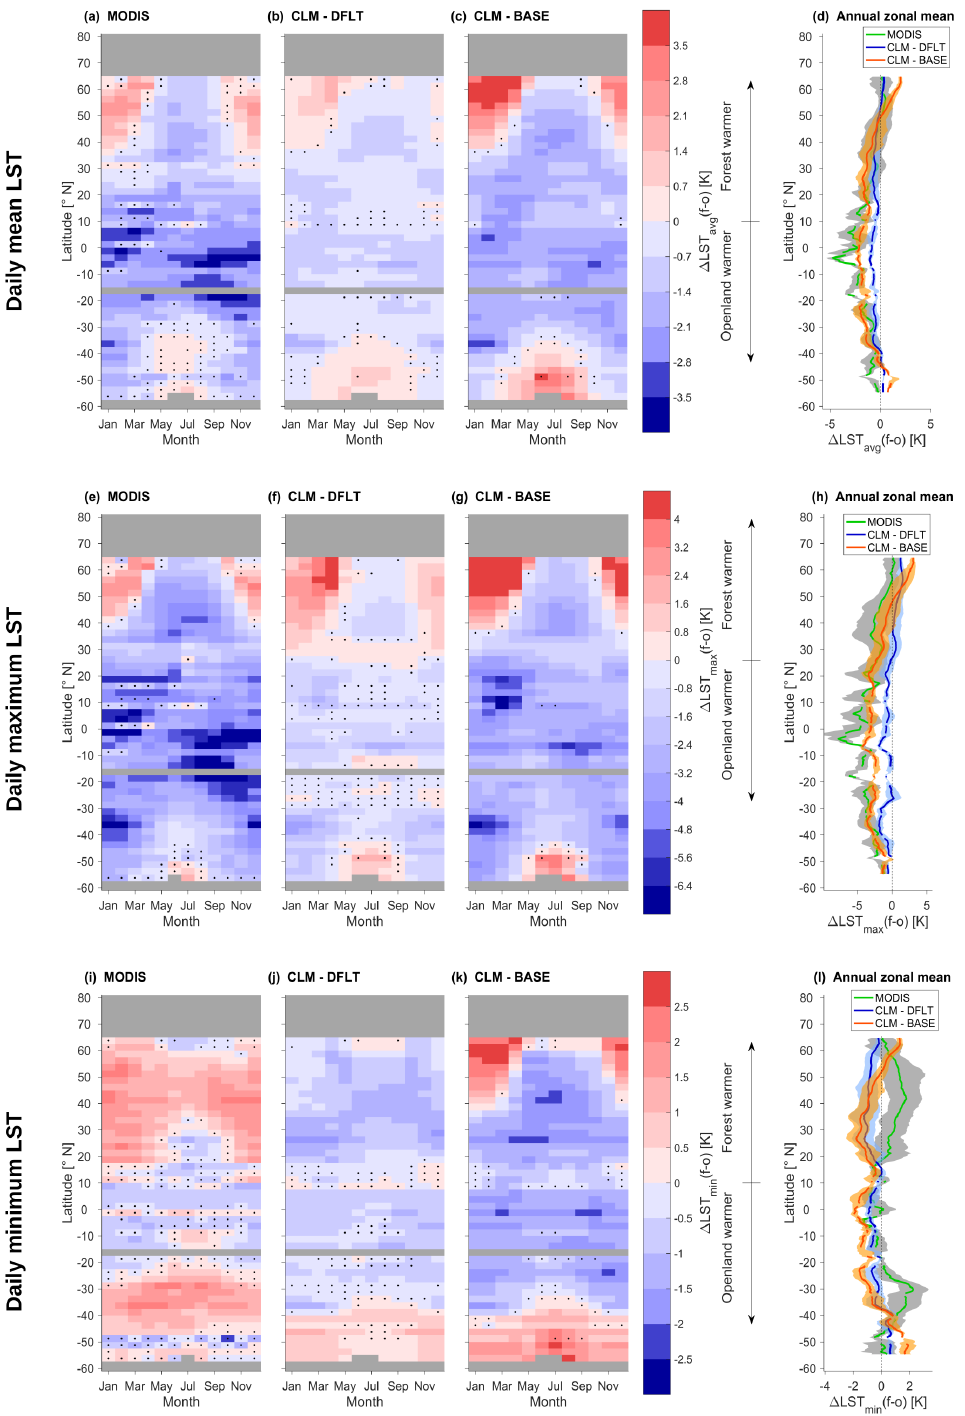
Figure 8. Seasonal and latitudinal variations of (cid:49) LST avg (f − o) in (a) the MODIS observations, (b) CLM-DFLT, and (c) CLM-BASE. Points with a mean which is insignificantly different from zero in a two-sided t test at 95% confidence level are marked with a black dot. Only grid cells containing valid data in the MODIS observations were considered for the analysis of CLM-DFLT and CLM-BASE. All data from the 2002–2010 analysis period corresponding to a given latitude and a given month are pooled to derive the sample set for the test. Panel (d) shows the zonal annual mean of MODIS (green, range between the 10th and 90th percentiles in grey), CLM-DFLT (blue, range between the 10th and 90th percentiles in blue), and CLM-BASE (red, range between the 10th and 90th percentiles in orange). Note that on this subfigure results have been smoothed with a 4 ◦ latitudinally running mean. The same was done for (cid:49) LST max (f − o) in panels (e) , (f) , (g) , and (h) , and for (cid:49) LST min (f − o) in panels (i) , (j) , (k) , and (l)